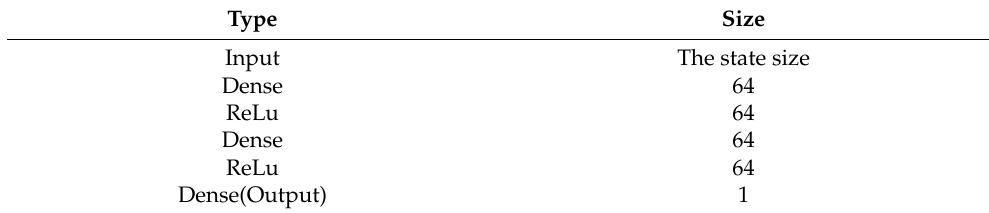
Table 4. Deep learning network architecture.